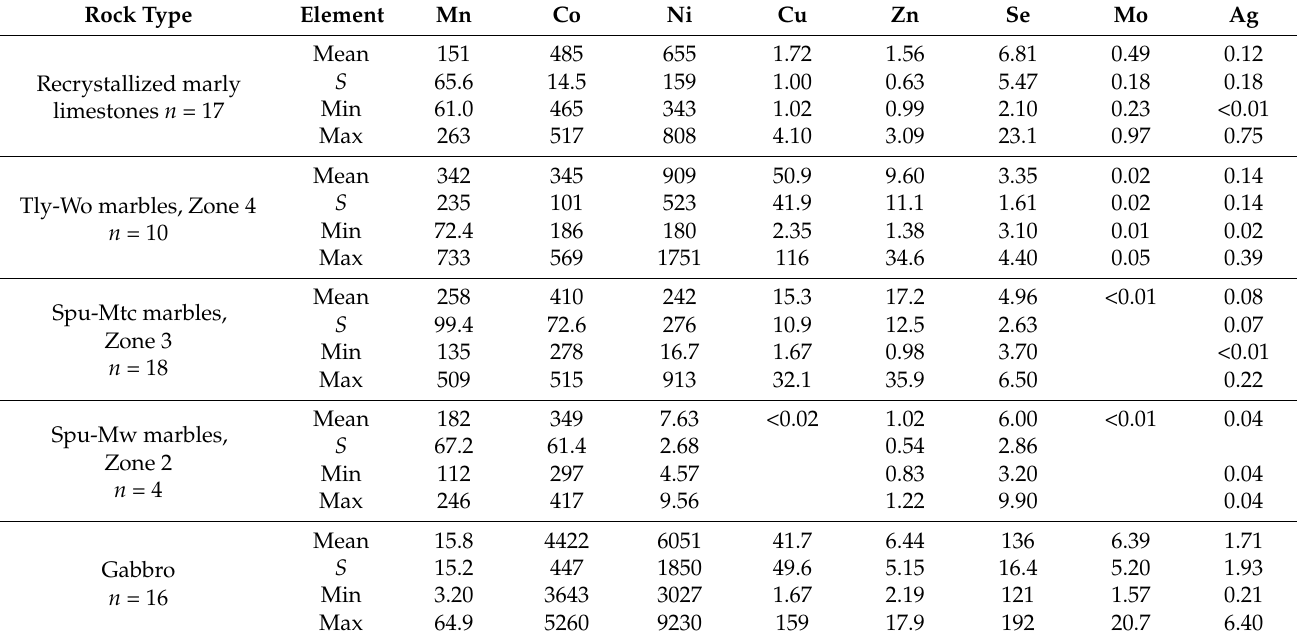
Table 8. Average trace element compositions of pyrrhotite from recrystallized marly limestones, marbles, and gabbro from the Kochumdek contact aureole (LA-ICP-MS data,